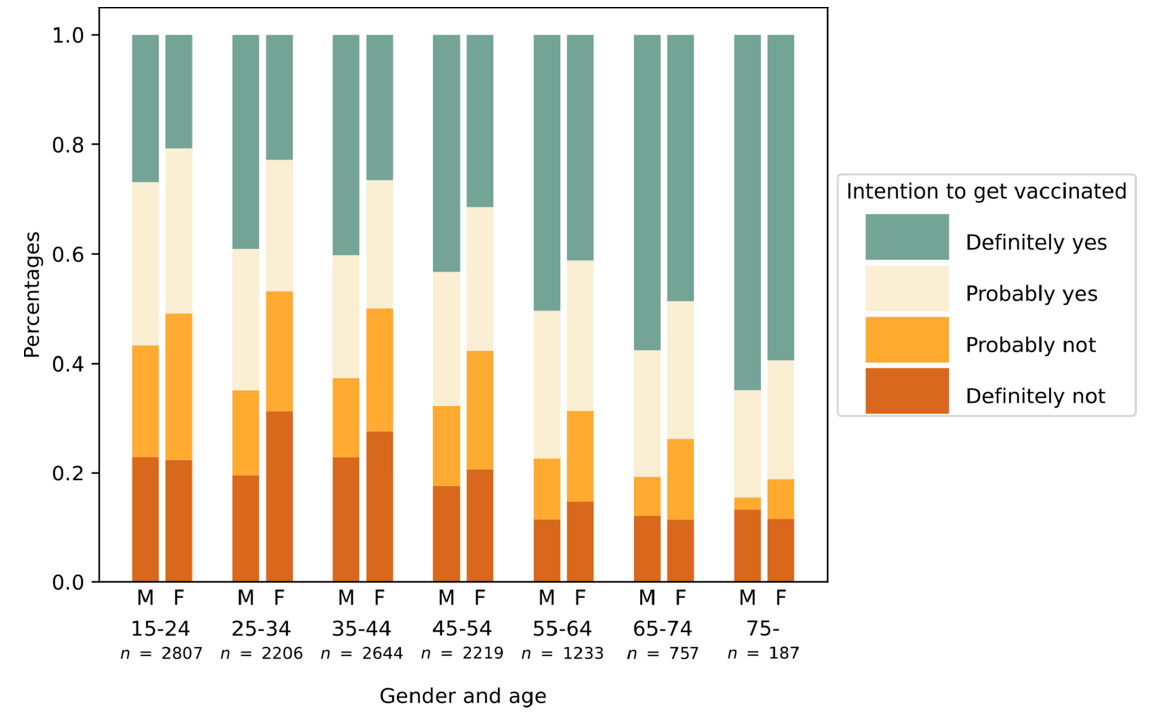
Vaccines 2021 , 9 , x FOR PEER REVIEW Figure 2. Intention to get vaccinated by age group and gender (M: male, F: female). In the past, only 18% of respondents had been regularly vaccinated against influenza. A strong association was observed between prior vaccination against influenza and a pos- itive attitude towards vaccination against SARS-CoV-2 (43% vs. 78%, p < 0.001, Chi Square = 1542.675, Contingency Coeff. = 0.337) (Figure 3).